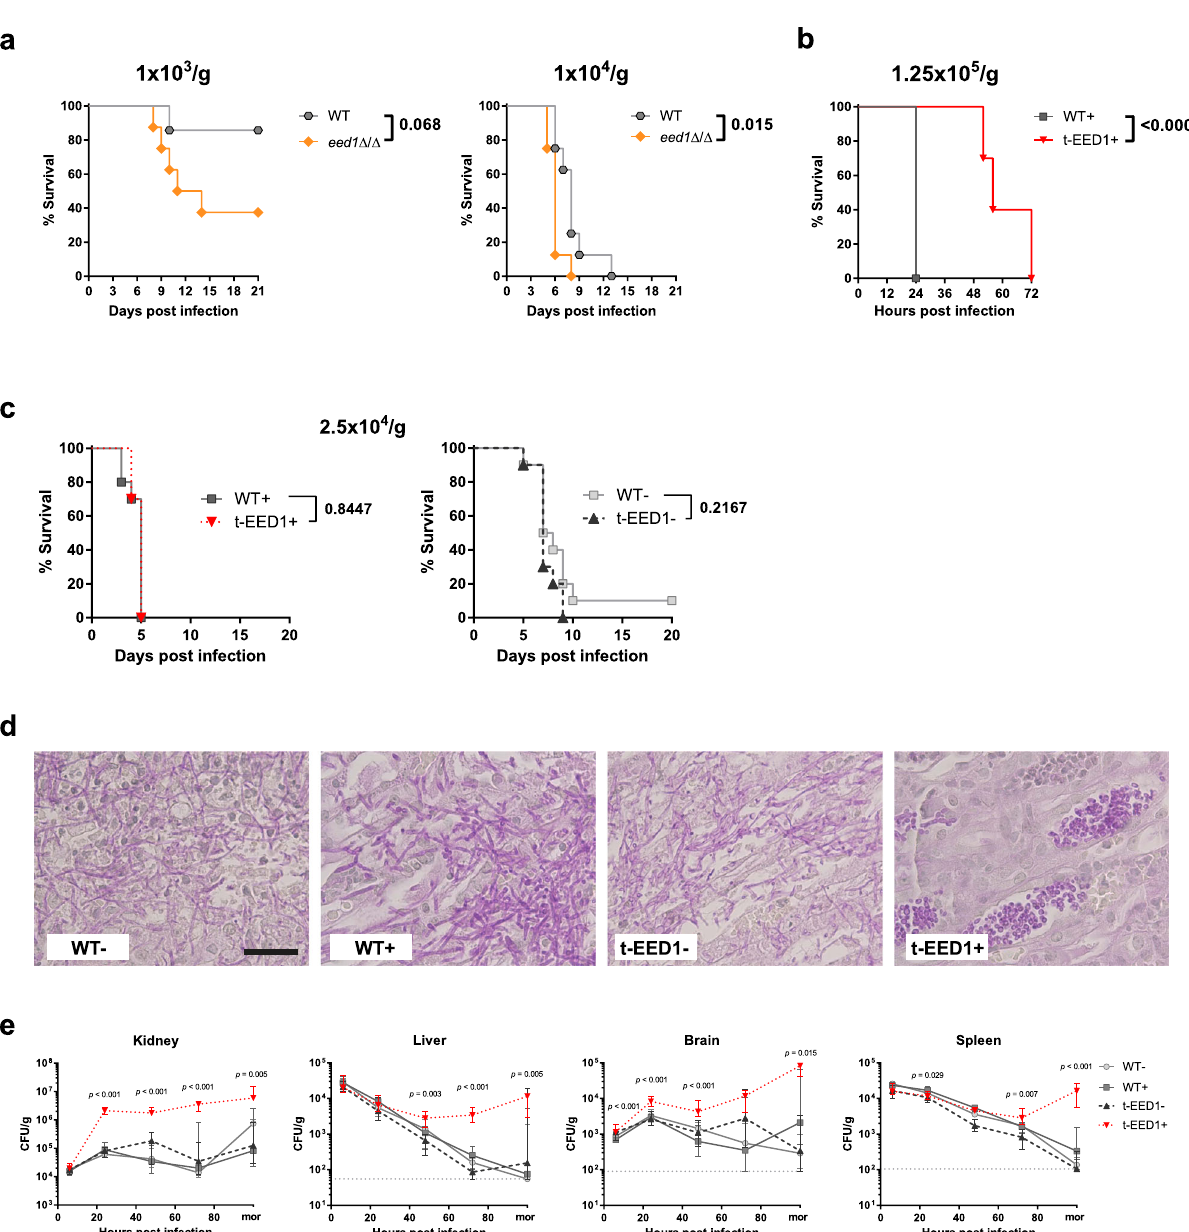
Fig. 3 C. albicans retains its virulence potential in a mouse model of systemic candidiasis even in the absence of hyphal elongation due to repression or deletion of EED1 accompanied by higher organ fungal loads. Mice were intravenously infected with the following doses: a Low doses of 1 × 10 3 or 1 × 10 4 CFU/g body weight of WT (SC5314) or eed1 Δ / Δ mutant. One experiment, n = 8 mice per group (except for WT 1 × 10 3 , n = 7). b A high dose of 1.25 × 10 5 CFU/g body weight of WT (THE1-CIp10) or t-EED1 in the presence of doxycycline. One experiment, n = 10 mice per group. c An intermediate dose of 2.5 × 10 4 CFU/g body weight with WT (THE1-CIp10) or t-EED1 in the presence ( + ) or absence ( − ) of doxycycline. One experiment, n = 10 mice per group. a – c Survival was monitored over a course of 20 or 21 days and is shown as Kaplan – Meyer curve. Survival curves were compared using the two-sided Log-rank (Mantel – Cox) test, p -values are shown in the graph. d Representative images of PAS stained histological cross sections of kidneys from moribund mice infected with 2.5 × 10 4 CFU/g body weight with WT (THE1-CIp10) or t-EED1 in the presence ( + ) or absence ( − ) of doxycycline. Fungal cells are stained purple. Scale bar represents 20 µ m and applies to all images. e Organ fungal loads of mice infected with 2.5 × 10 4 CFU/g body weight with WT (THE1- CIp10) or t-EED1 in the presence ( + ) or absence ( − ) of doxycycline. Shown is the number of CFU per gram organ from mice sacri fi ced 6, 24, 48 and 72 h post infection and from moribund mice (mor). Data are shown as median with interquartile range. Dashed gray lines indicate limit of detection. Moribund: one experiment, n = 10; Kidney: two independent experiments n = 10. Liver, spleen, brain: three independent experiments, n = 15. Two-sided Mann – Whitney test, asterisks indicate signi fi cant changes of t-EED1 + compared to WT + groups at the indicated time points. * p ≤ 0.05; ** p ≤ 0.01; *** p ≤ 0.001.